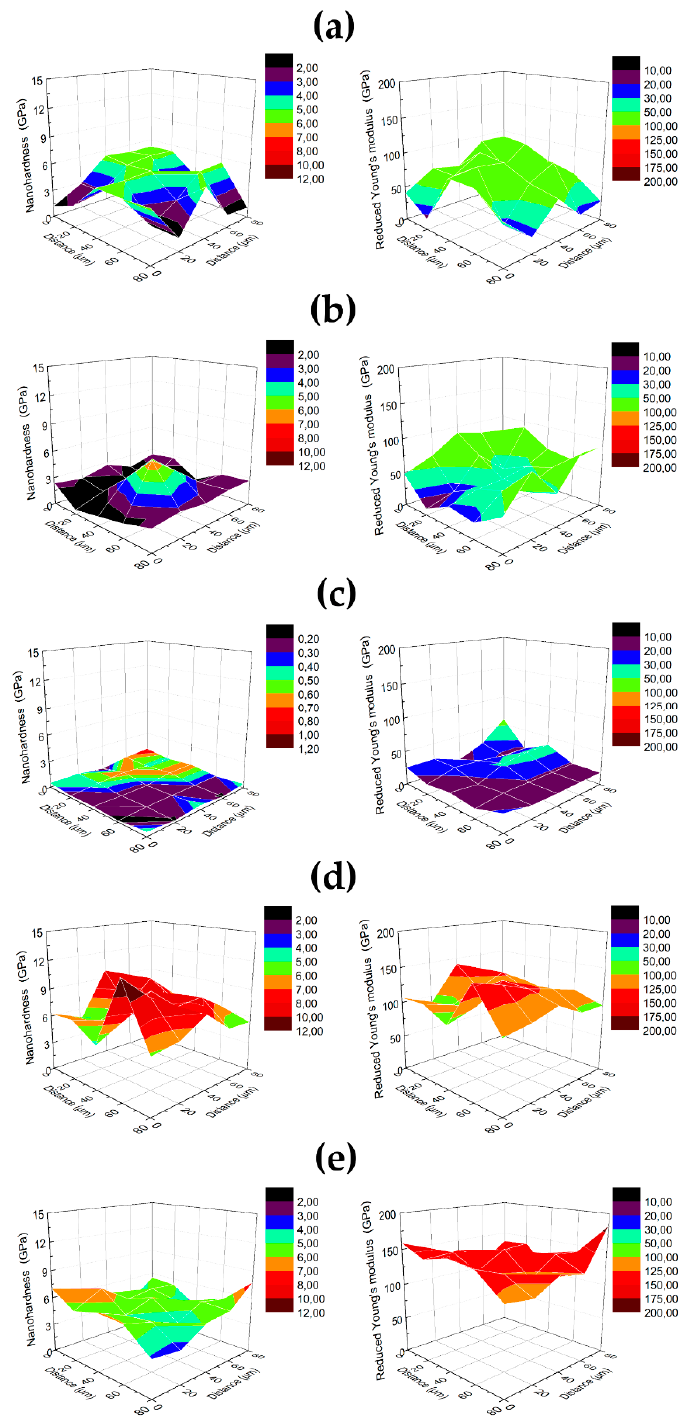
Figure 5. 3D maps of nanomechanical (nanohardness—left and Reduced Young’s modulus—right) properties of studied specimens after different surface treatments: ( a ) Untreated SLM; ( b ) Sandblasted SLM; ( c ) Etched SLM; ( d ) Ground SLM; and, ( e ) Solid bar.